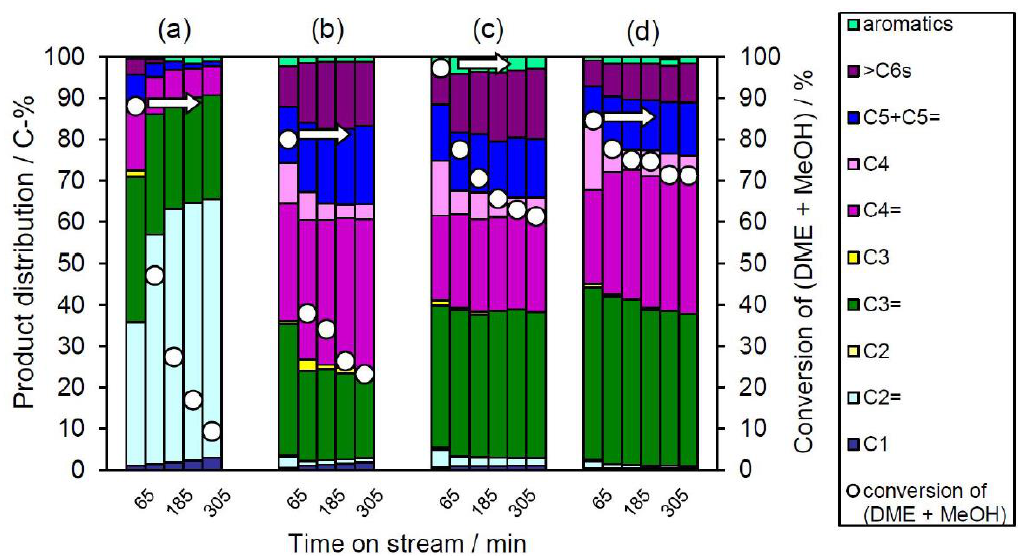
Figure 9. Results from the DTO reaction over the ( a ) SSZ-13 (Si / Al = 136), ( b , c ) deAl-YFI-C(287), and ( d ) beta (Si / Al = 250). Pretreatment conditions: 550 ◦ C; 1 h under an air flow of 40 cm 3 (NTP) · min − 1 . Reaction conditions: catalyst weight, 100 mg; W / F = 20 g-cat h mol − 1 with the exception of ( c ) where W / F = 79 g-cat h mol − 1 ; pellet size, 500–600 µ m; He flow rate, 40 cm 3 (NTP) min − 1 ; reaction temperature, 400 ◦ C. The nomenclature for deAl-YFI-C(287) is explained in Section 2.4. Coke amounts in the spent catalysts estimated by thermogravimetric analyses were ( a ) 91, ( b ) 29, ( c ) 25, and ( d ) 19 mg (g-cat) −1 .